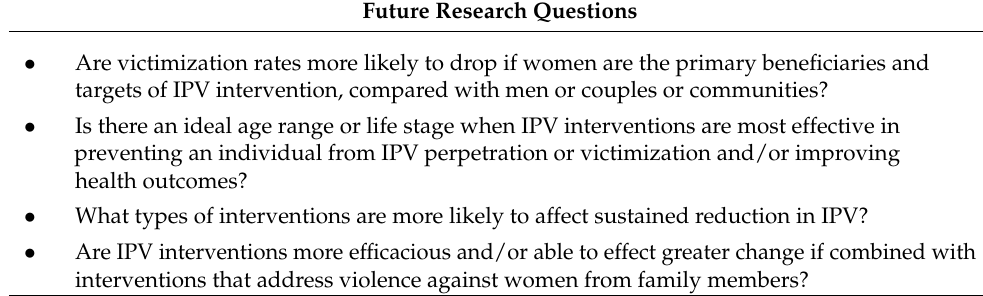
Table 5. Summary of questions for future